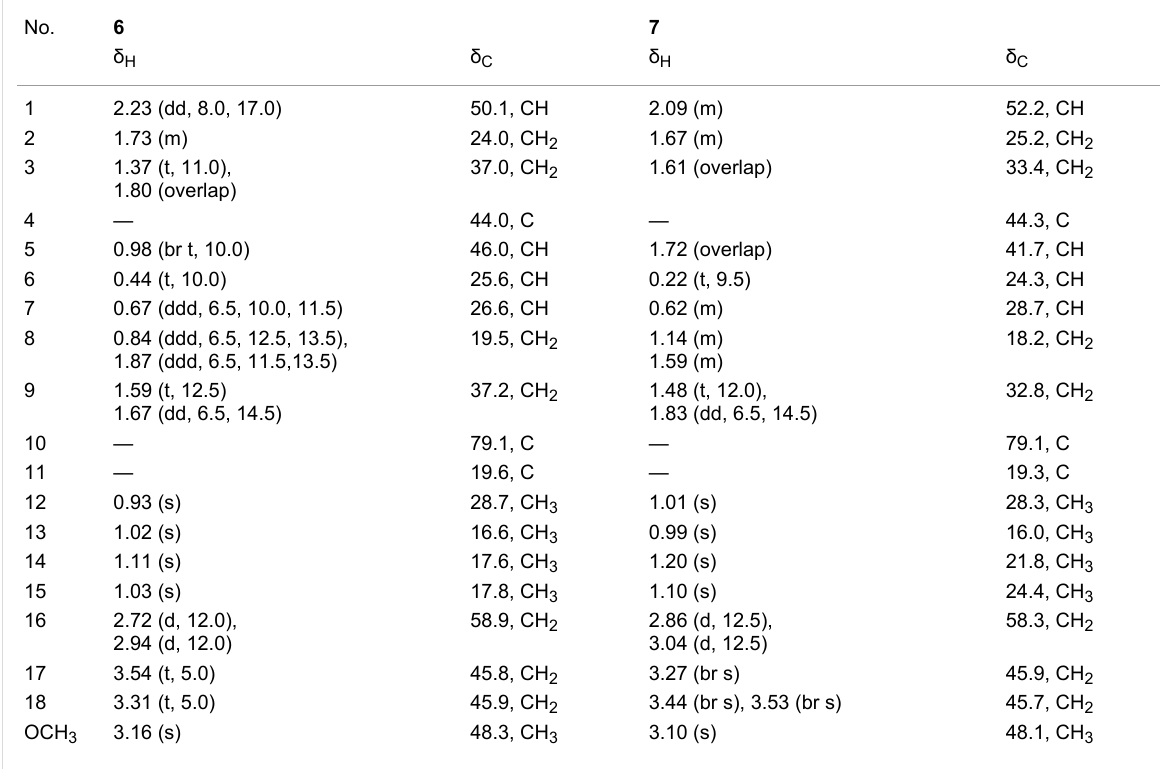
Table 2: 1 H (500 MHz) and 13 C NMR (125 MHz) data of 6 and 7 (in CDCl 3 , δ in ppm, J in Hz).